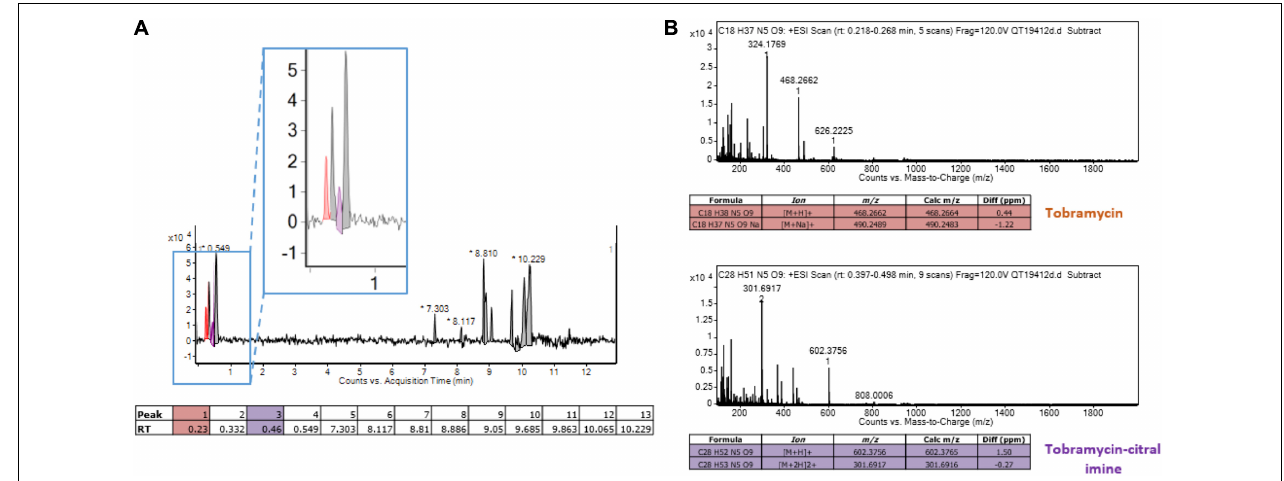
FIGURE 6 | Detection of a monoadduct of citral-tobramycin. (A) Liquid chromatography of a mixture tobramycin and citral (ratio 1/600). The peak corresponding to tobramycin is colored in orange and the peak corresponding to the tobramycin-citral imine is colored in purple. (B) Mass spectrometry analysis (Electrospray in positive mode) of tobramycin and tobramycin-citral imine from liquid chromatography. The target ions/formulas are displayed in the